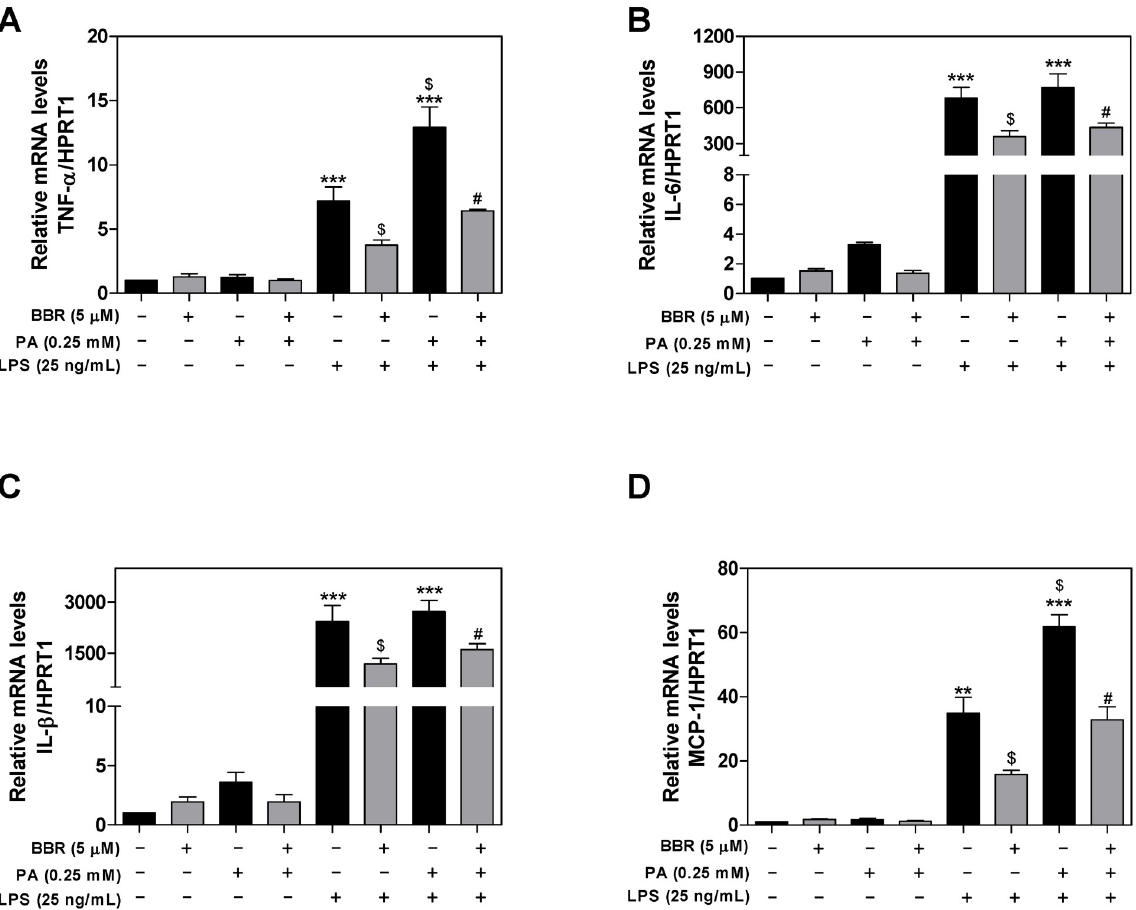
Fig 1. Effect of BBR on PA and LPS-induced mRNA expression of proinflammatory mediators in RAW264.7 cells. RAW264.7 cells were pretreated with BBR (5 μ M) for 1 h, then treated with palmitic acid (PA, 0.25 mM) or LPS (25 ng/mL) or both for 6 h. The mRNA levels of TNF- α , IL-6, MCP-1, and IL-1 β were detected by real-time RT-PCR and normalized to HPRT1 as an internal control as described under Materials and Methods. Values are mean ± S.E. of three independent experiments. Statistical significance relative to vehicle control, �� p < 0.01, ��� p < 0.001; relative to LPS, $ p < 0.05; relative to PA+LPS, # p < 0.05. A . TNF- α ; B . IL-6; C . IL-1 β ; D . MCP-1.